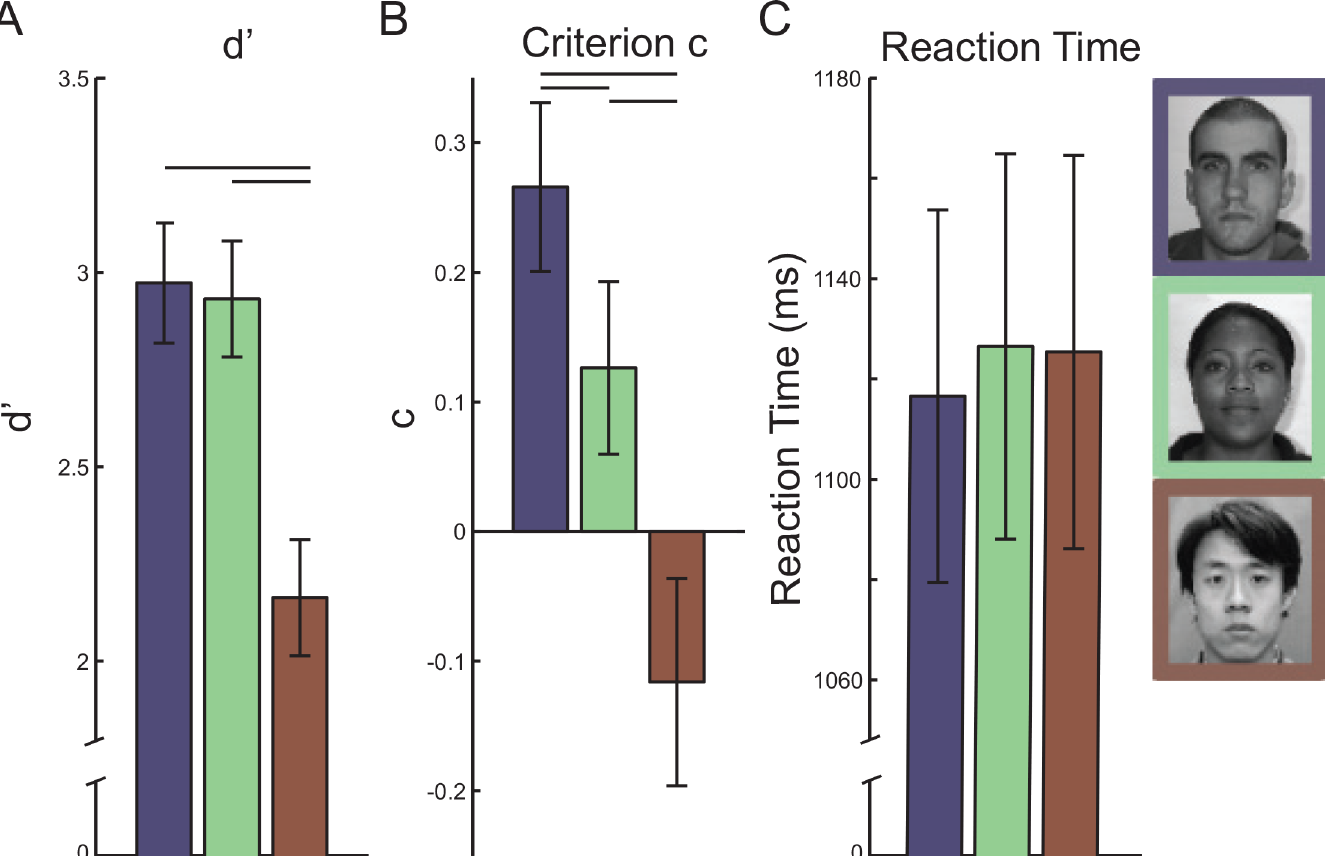
Fig 2. Effects of race of face on recognition performance. (a) Face recognition performance, measured by d ’ , was significantly lower for Chinese compared to Caucasian and African faces. (b) Criterion scores for Caucasian faces were higher (stricter) than African and Chinese faces. Also criterion scores for African faces were higher than for Chinese faces. (c) Reaction times did not differ among different race faces. Error bars indicate the between- subjects standard error.